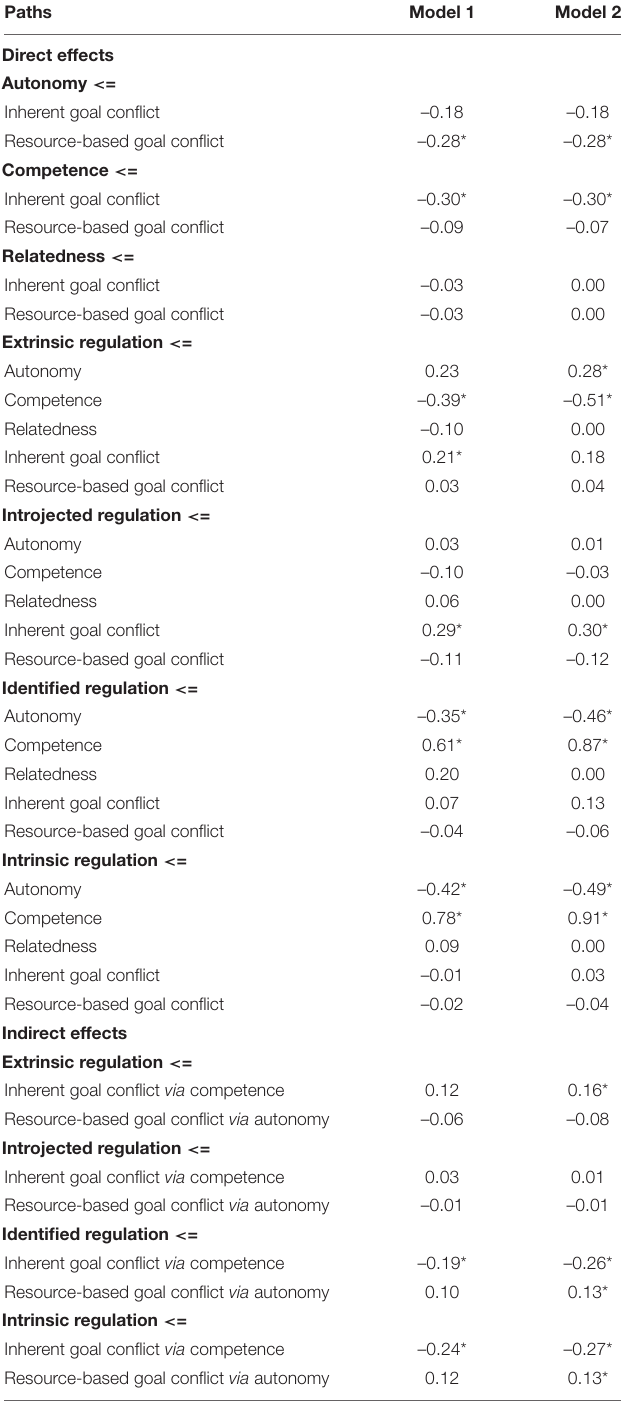
Table depicts standardized path coefficients with bootstrapped p-values; Model 1: frequency of experiencing inherent and resource-based goal conflict predict extrinsic, introjected, identified and intrinsic regulation of teaching motivation partially mediated by the satisfaction of the basic need for autonomy, competence, and relatedness; Model 2: Model 1 with autonomy and competence as mediators, for further description see text; * p <